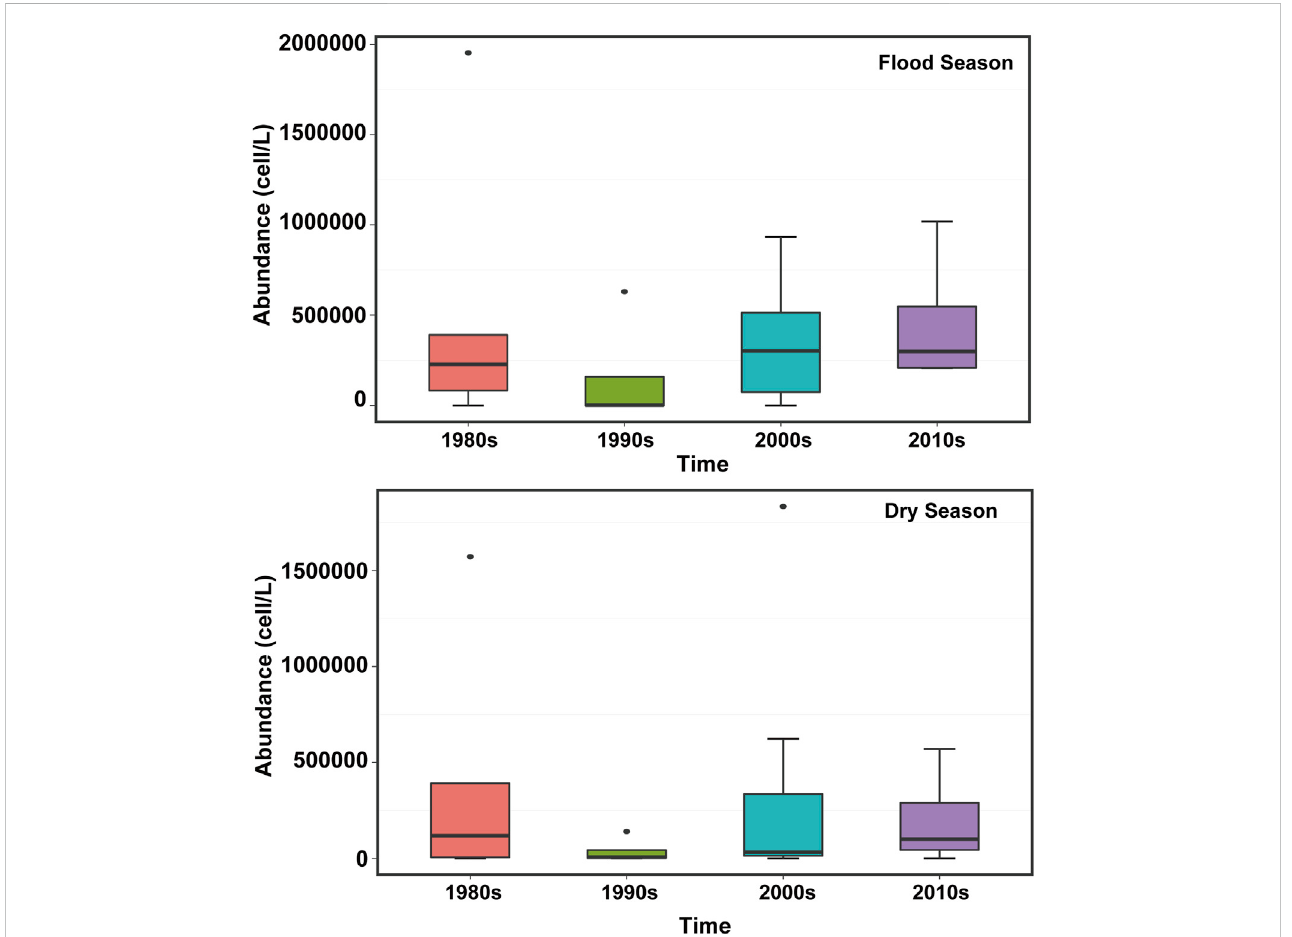
Variation characteristics of phytoplankton abundance inthe Pearl River Estuary during the fl ood and dry seasons from the 1980s – 2020s (Linet al., 1994; HuangandWang,1997;Huangetal.,2004;Liu,2008;Lietal.,2010;Fengetal.,2012;Wangetal.,2012;Lietal.,2022;Zhangetal.,2015;Lietal.,2019;Lietal., 2022; Xu et al.,